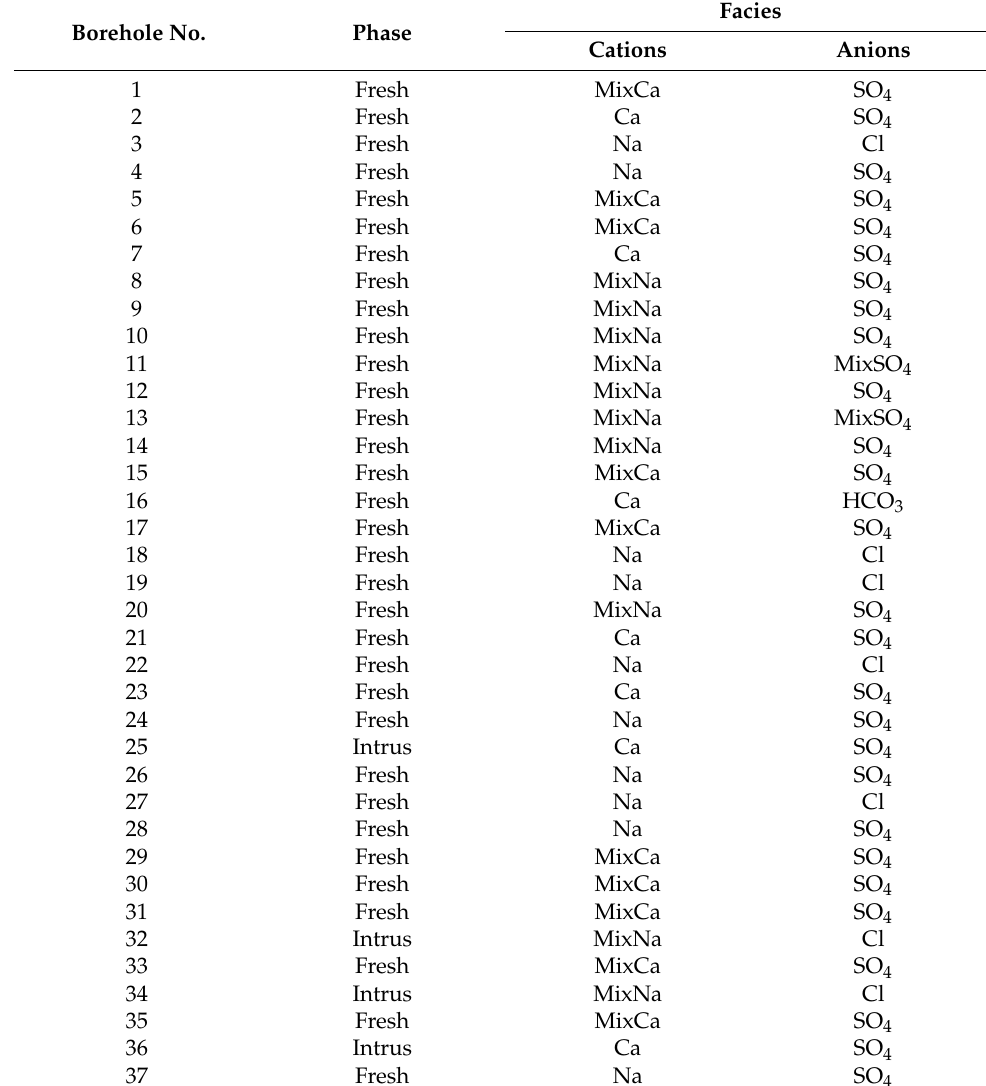
Table 3. Phases and facies of groundwater samples in the Sfax coastal shallow aquifer. Borehole